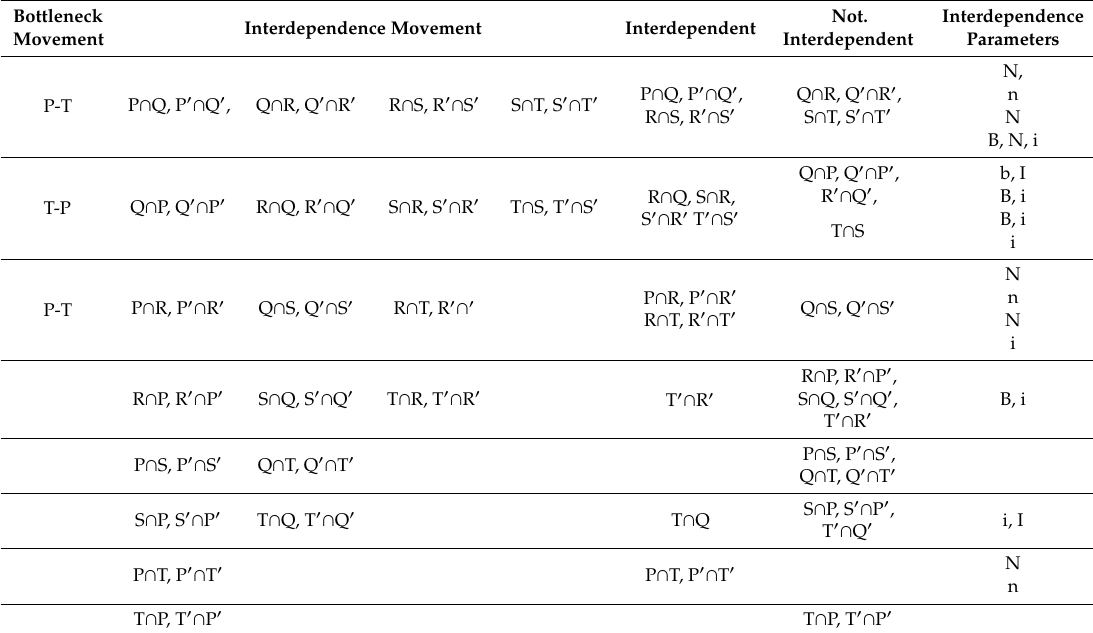
Not. Interdependence Interdependent